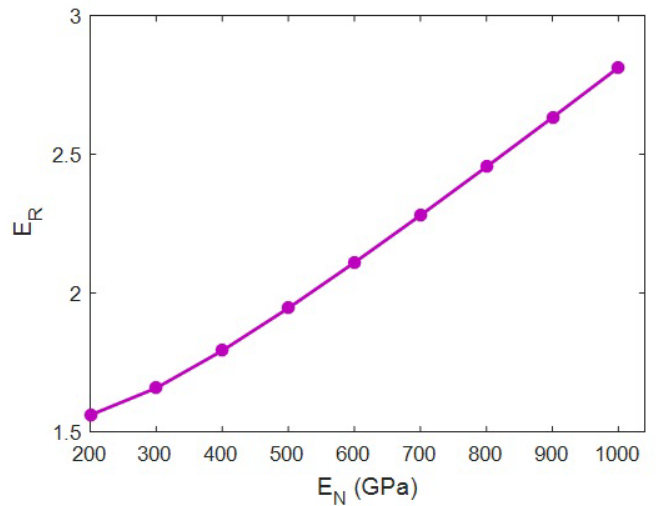
Figure 6. Relation between the moduli of HNT network and whole system according to Equation